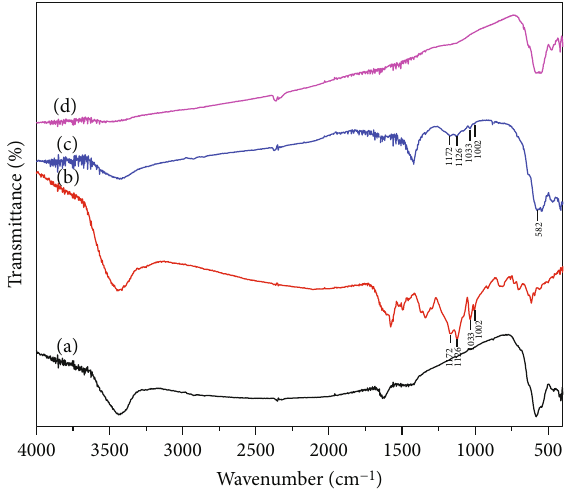
Figure 7: FTIR spectrum of CaFe O nanosheets after adsorption (c), and the regenerated CaFe 2 4 CaFe O nanosheets 2 4